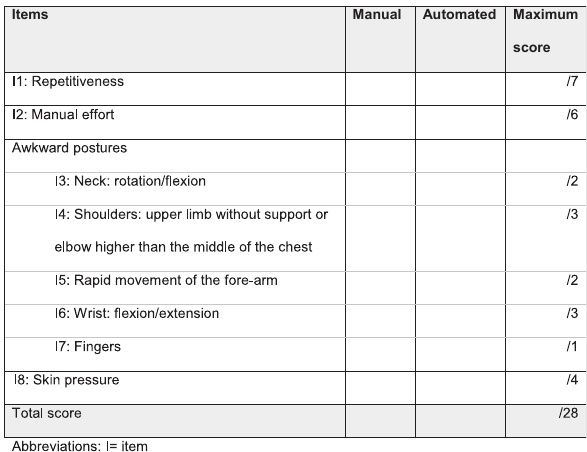
Figure 2: Self-evaluation questionnaire.